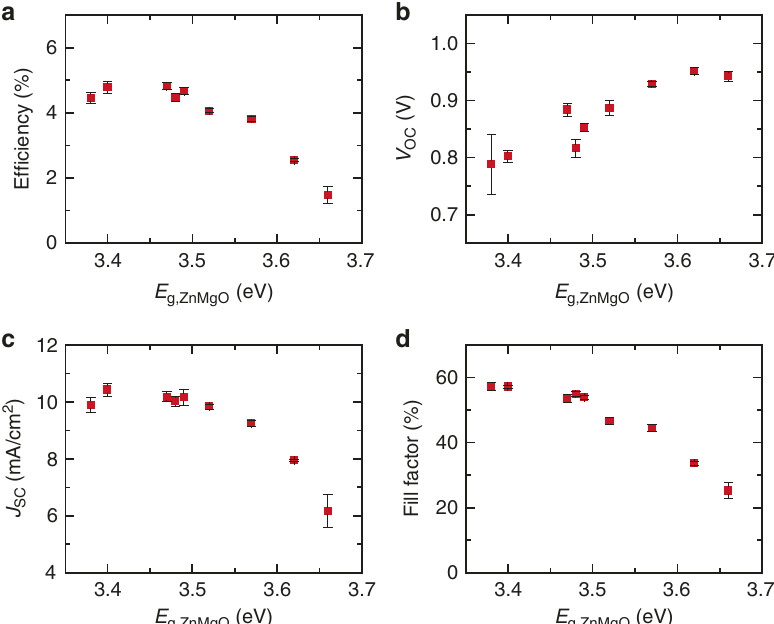
Fig. 3 Effects of band gap ( E g ) of ZnMgO buffer layer on the photovoltaic characteristics. a Power conversion ef fi ciency, b Open-circuit voltage ( V OC ), c Sort circuit current ( J SC ), and d fi ll factor of the ZnMgO/Se/MoO x /Au devices prepared by the combinatorial deposition process are plotted against measured E g of ZnMgO layer. Square symbols and error bars indicate average values and standard deviations,